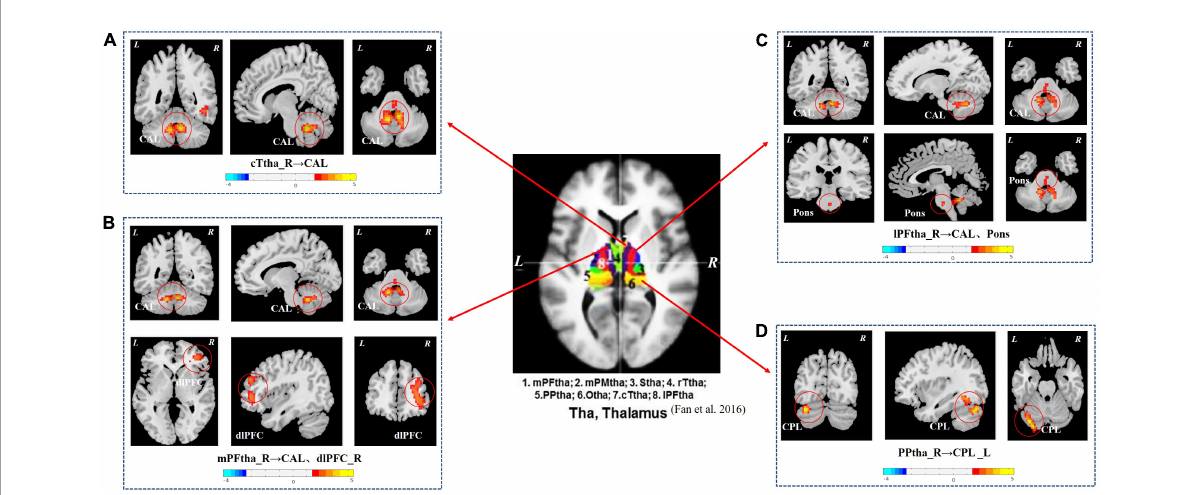
FIGURE1 The group differences in thalamus rs-FC network (CSU vs. HCs). (A) Seeds within the cTtha_R of patients with CSU showed increased rs-FC with the CAL. (B) Seeds within the mPFtha_R showed increased rs-FC with both CAL and dlPFC_R. (C) Seeds within the lPFtha_R showed increased rs-FC with both CAL and pons. (D) Seeds within the PPtha_R showed increased rs-FC with the CPL_L. Warm colors represent increased rs-FC values. rs-FC, resting-state functional connectivity; CSU, chronic spontaneous urticaria; HCs, healthy controls; L, left; R, right; cTtha, caudal temporal thalamus; mPFtha, medial prefrontal thalamus; lPFtha, lateral prefrontal thalamus; PPtha, posterior parietal thalamus; CAL, cerebellum anterior lobe; dlPFC, dorsal lateral prefrontal cortex; CPL, cerebellum posterior lobe.